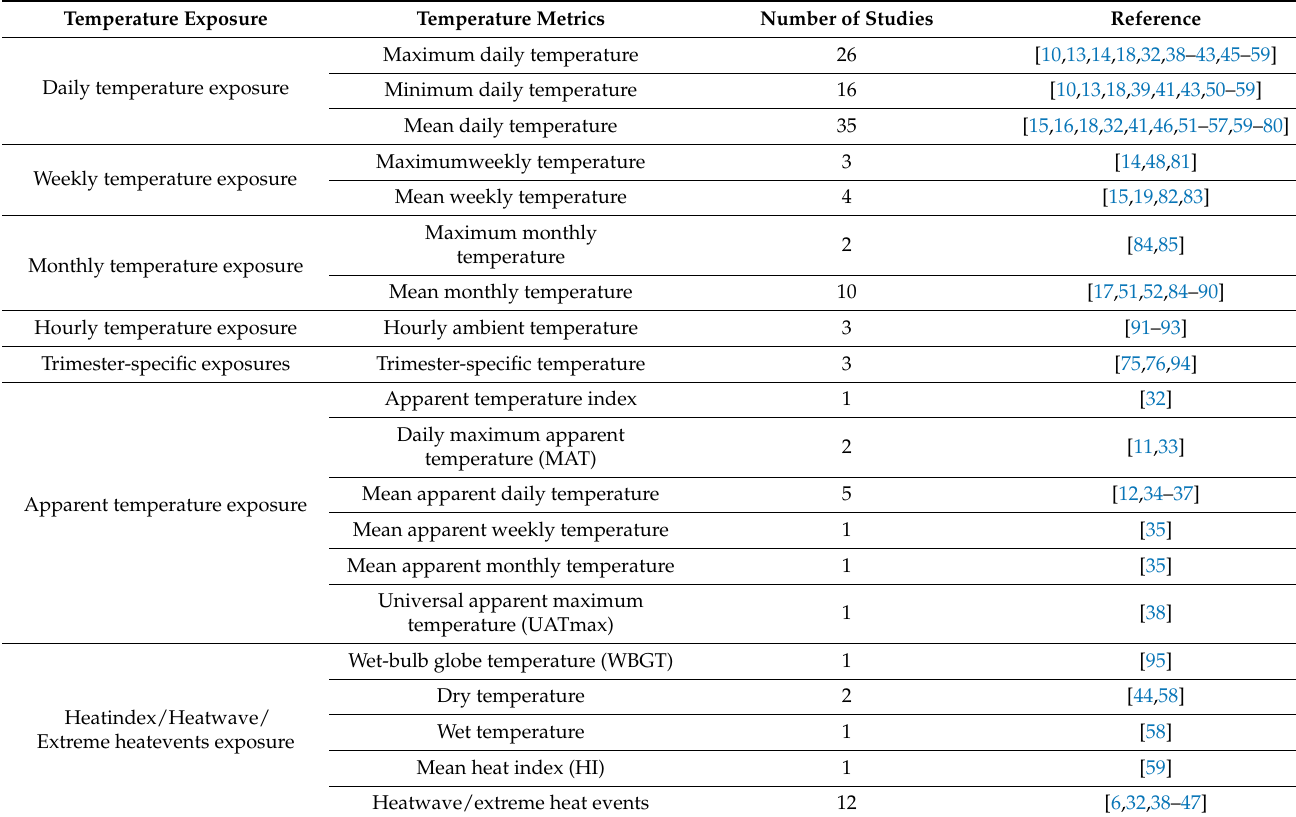
Table 1. Temperature metrics used among reviewed studies.